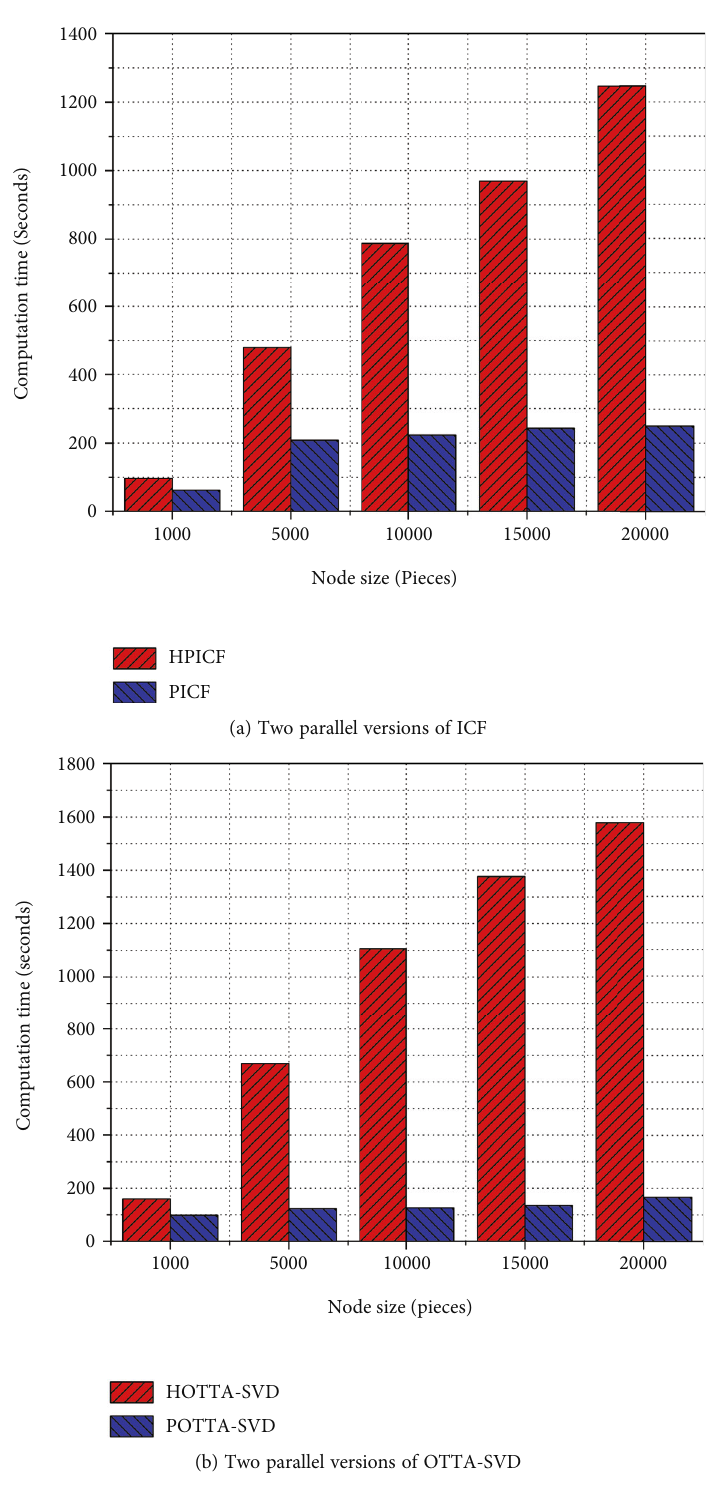
Figure 13: Comparison of di ff erent parallel performances of recommendation algorithms in di ff erent scale data Figure 11 lists the in fl uence of the number of latent fea- tures F on the recommendation accuracy in various recom- mendation algorithms. Simulation experiments show that the recommendation e ff ect of the OTTA-SVD algorithm is the best.